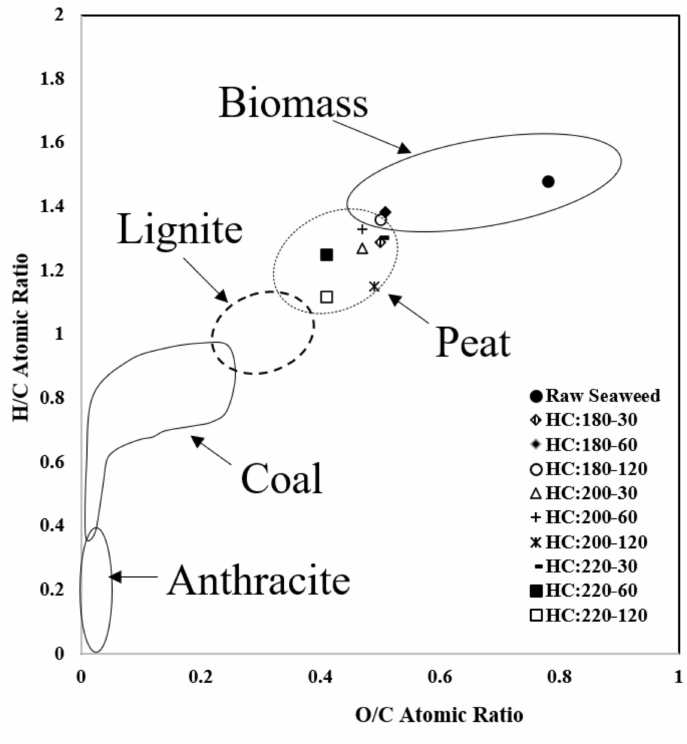
Figure 7. Atomic H/C–O/C ratios for the hydrochar samples and the raw seaweed.